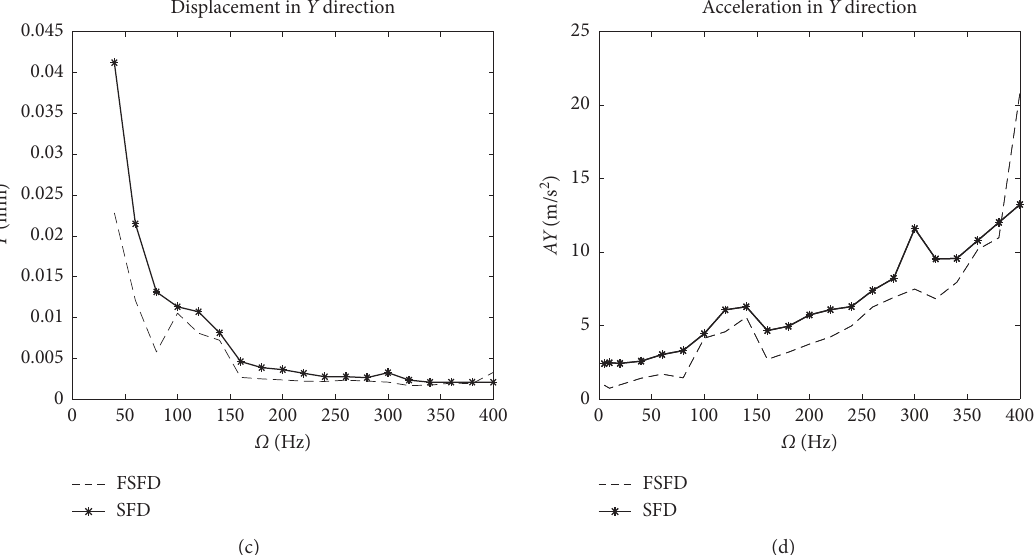
Figure 16: DCSFD vs. SFD for support 2: (a) X directional displacement; (b) X directional acceleration; (c) Y directional displacement; (d) Y directional